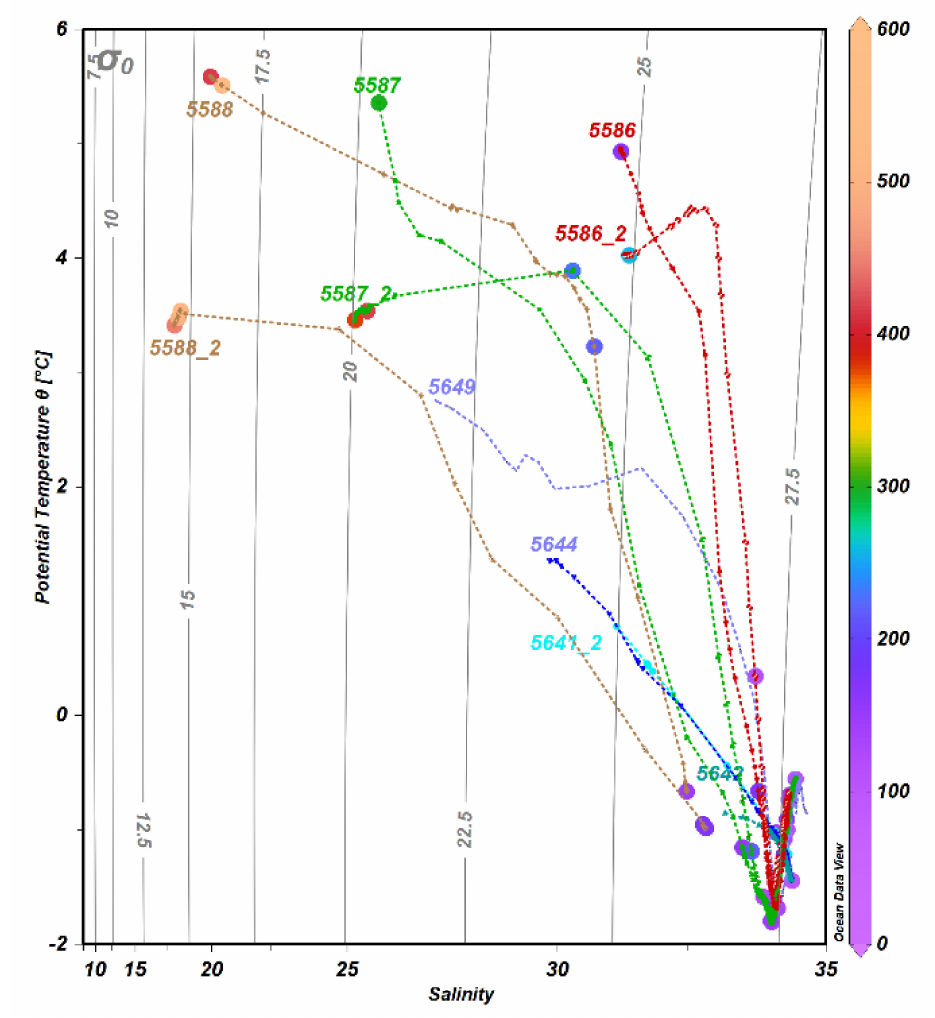
Figure 3. Temperature—salinity diagram for CTD profiles observed in the Kara Sea in Autumn, 2017. Color coding indicates DOC concentration ( µ